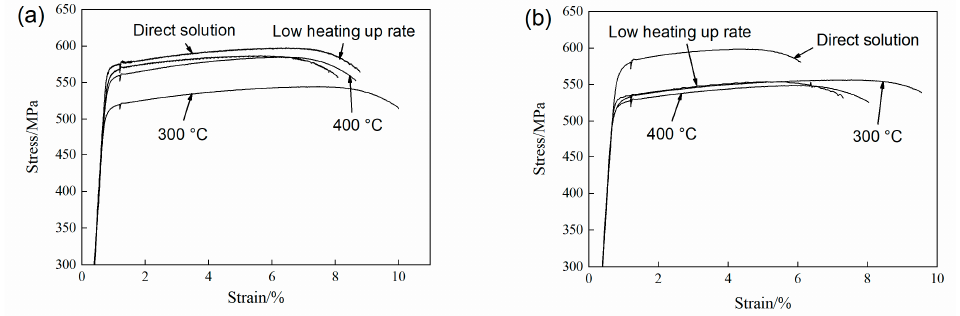
Figure 8. Tensile curves of the aged 2195 Al ‐ Li alloy sheets with different annealing treatment after aging following solution at 505 ◦ C ( a ) longitudinal direction and ( b ) transverse direction. T8 aging following solution at 505 °C ( a ) longitudinal direction and ( b ) transverse direction.